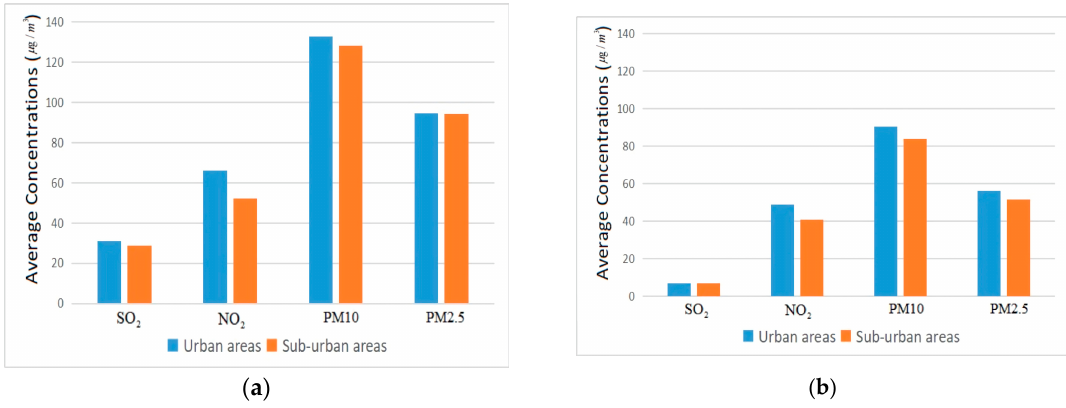
Figure 1. Average air pollution levels between urban and sub-urban areas in 2014 and 2018. ( a ) Average air pollution levels between urban and sub-urban areas in 2014, ( b ) Average air pollution levels between urban and sub-urban areas in 2018.